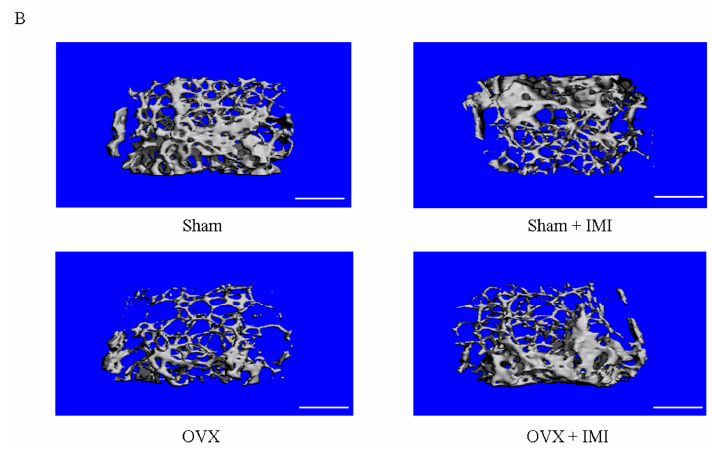
Figure 6. Imipramine protects against ovariectomy-induced bone loss. ( A ) Bone mineral density (BMD) of the femur was assessed on day 3 before mice were sacrificed at the end of the experiment; ( B ) Representative three-dimensional images of spinal bone were generated from micro-CT analysis. Each bar represents the mean ± standard deviation of eight mice. Scale bar, 0.5 mm. Statistical significance determined by two-way ANOVA is designated as follows: * p < 0.05 versus sham group; + p < 0.05 versus OVX group.